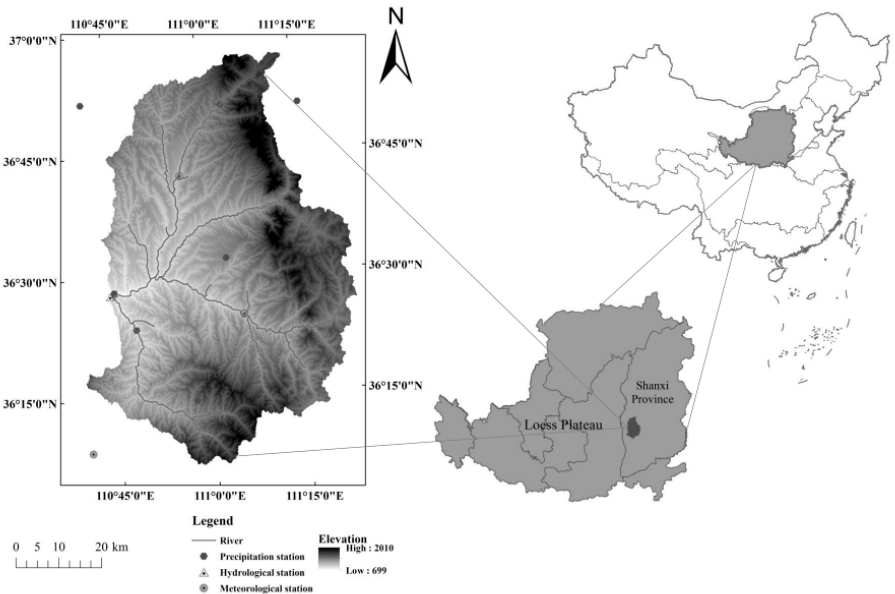
Figure 1. Location, topography, channel system, and measurement stations of Xinshui watershed.